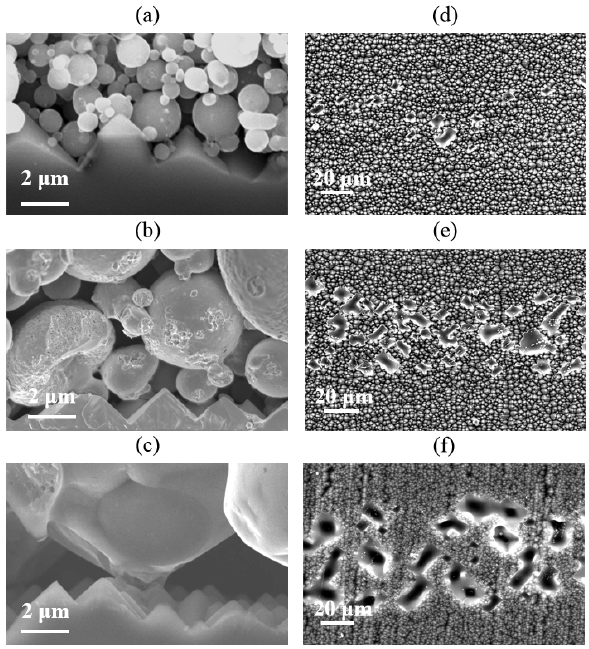
Figure 15. ( a–c ) Cross section SEM images; ( d–f ) Si substrate surface etched area after the paste’s removal. Figure 15. ( a – c ) Cross section SEM images; ( d – f ) Si substrate surface etched area after the paste’s